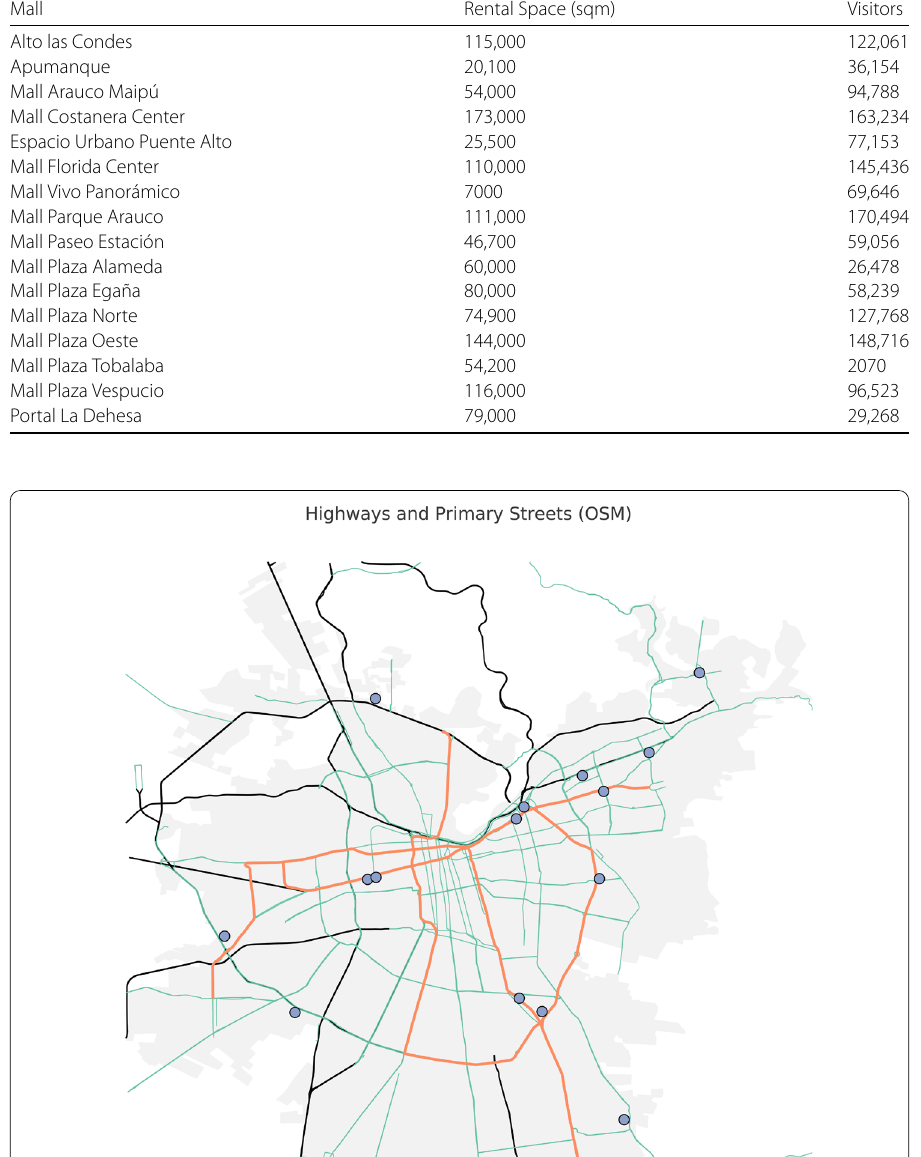
field in the dataset; (ii) by drawing each mall’s polygon and using the towers’ coordinates to determine which ones were inside the polygons. b Both methods turned out to be highly consistent. Our selection process yielded 481 indoor cellphone antennas placed inside